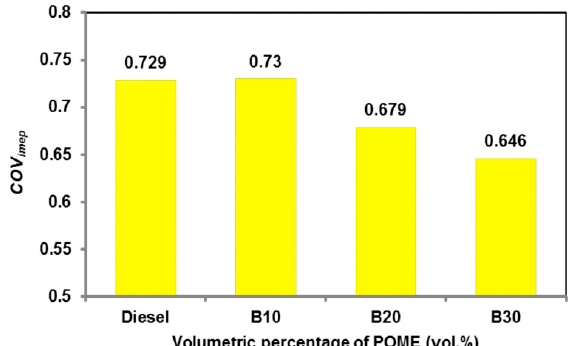
Figure 4. Coefficient of variation in indicated mean effective pressure ( COV IMEP ) of palm biodiesel–diesel blended fuel and mineral diesel [44].